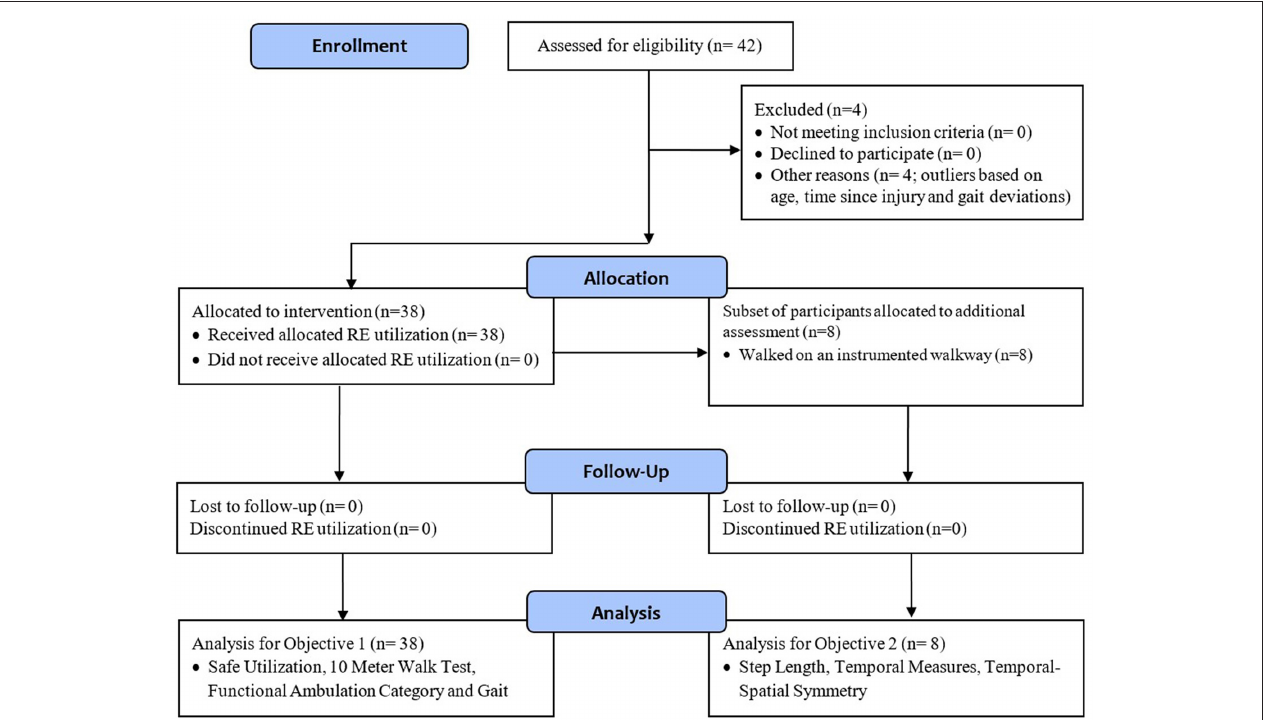
FIGURE 1 | Consort